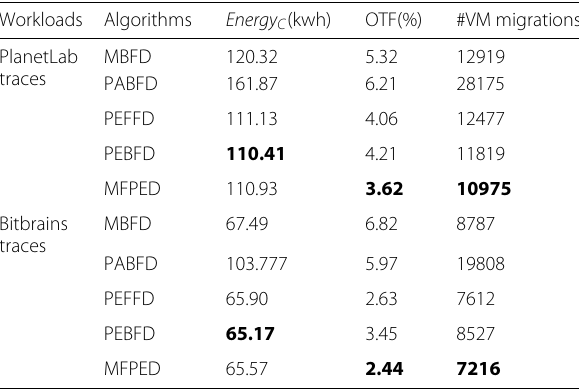
Table 4 Average performance of algorithms in the